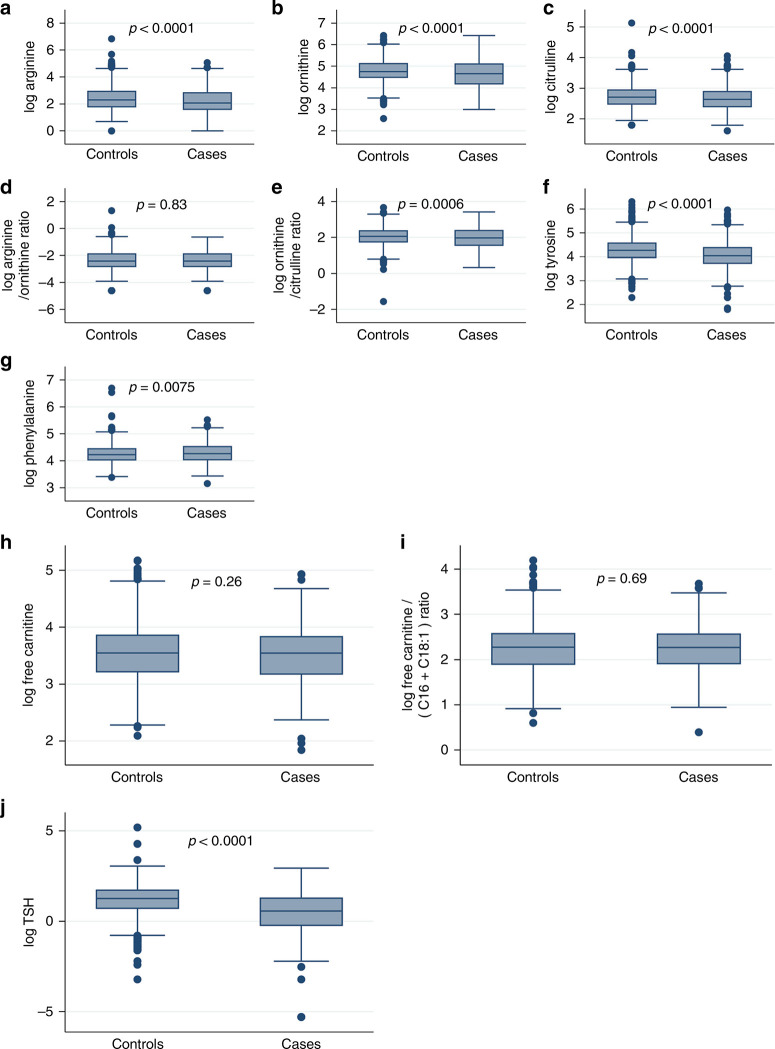
Boxplot of selected metabolites comparing cases and controls. a Log-transformed arginine, b log-transformed ornithine, c log- transformed citrulline, d log-transformed arginine/ornithine ratio, e log-transformed ornithine/citrulline ratio, f log-transformed tyrosine, g log-transformed phenylalanine, h log-transformed free carnitine, i log-transformed free carnitine/(acylcarnitine C16 and acylcarnitine C18) ratio, j log-transformed TSH